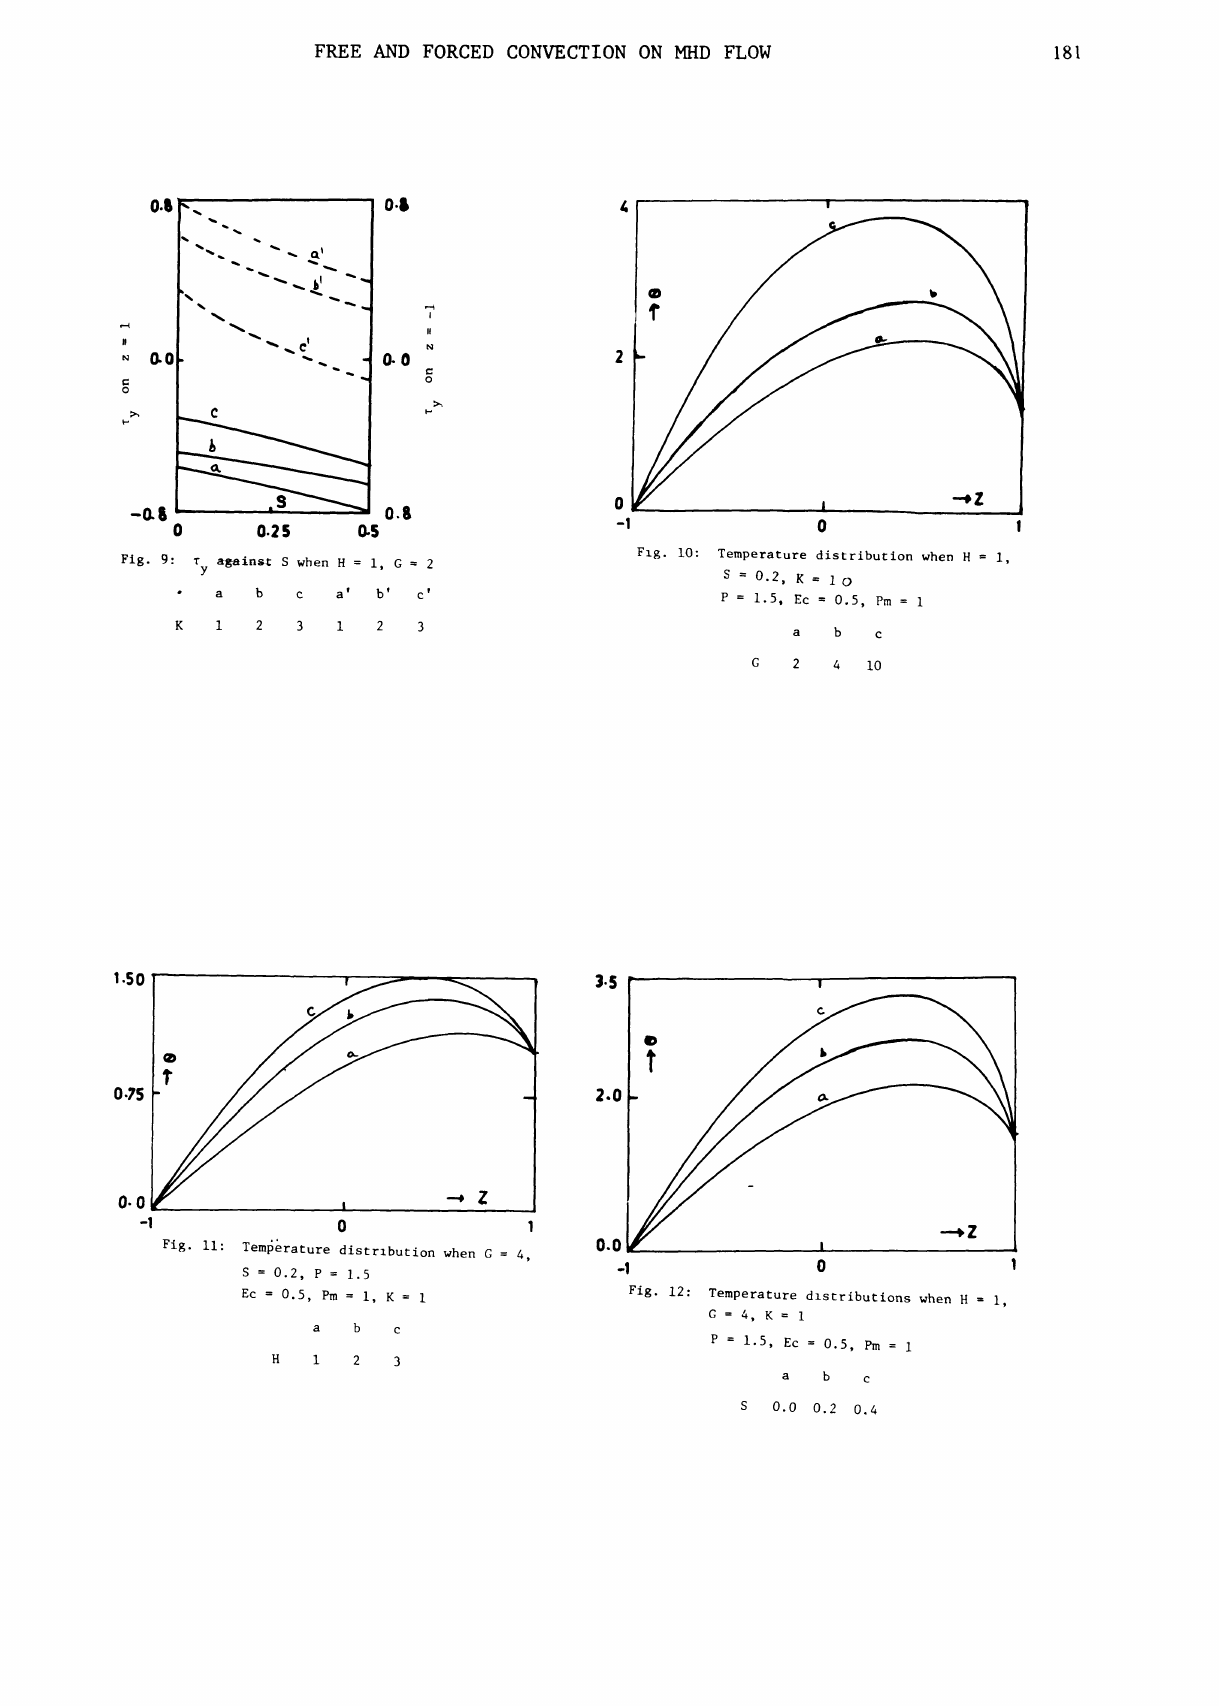
Fig. 12: Temperature dstributions when